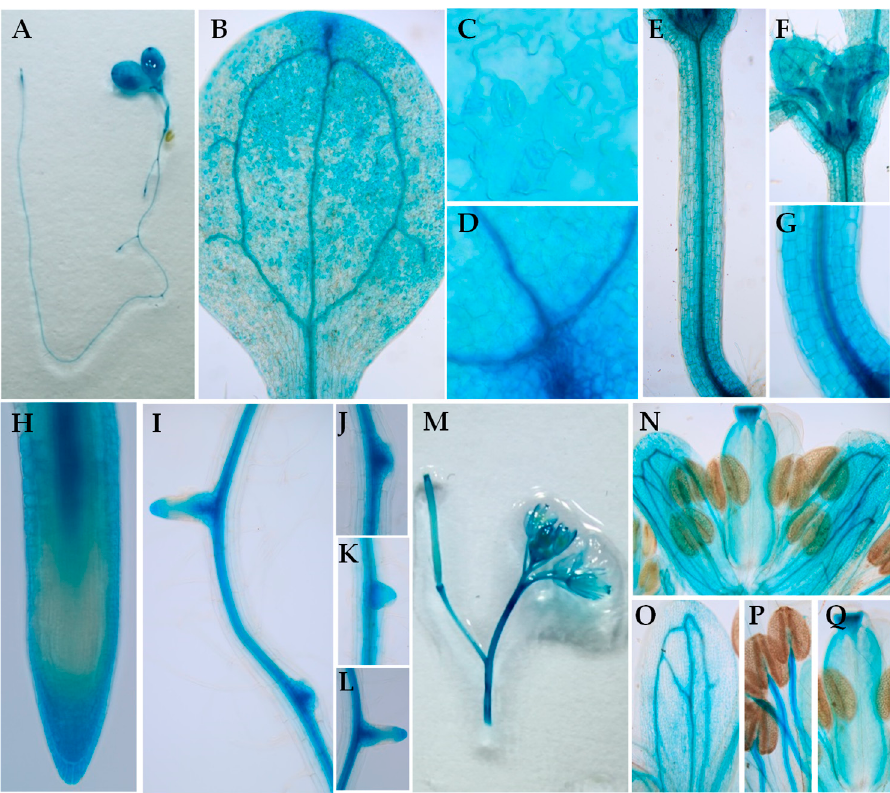
Figure 3. The expression pattern of BIG5 in Arabidopsis. ( A – Q ) The expression patterns of pBIG5: GUS in 7 dag Arabidopsis seedling ( A ), cotyledon ( B ), epidermal cells ( C ), vascular structure ( D ), a hypocotyl ( E ), young leaves ( F ), stele cells ( G ), root tip ( H ), lateral roots ( I – L ), and flowers ( M – Q ).